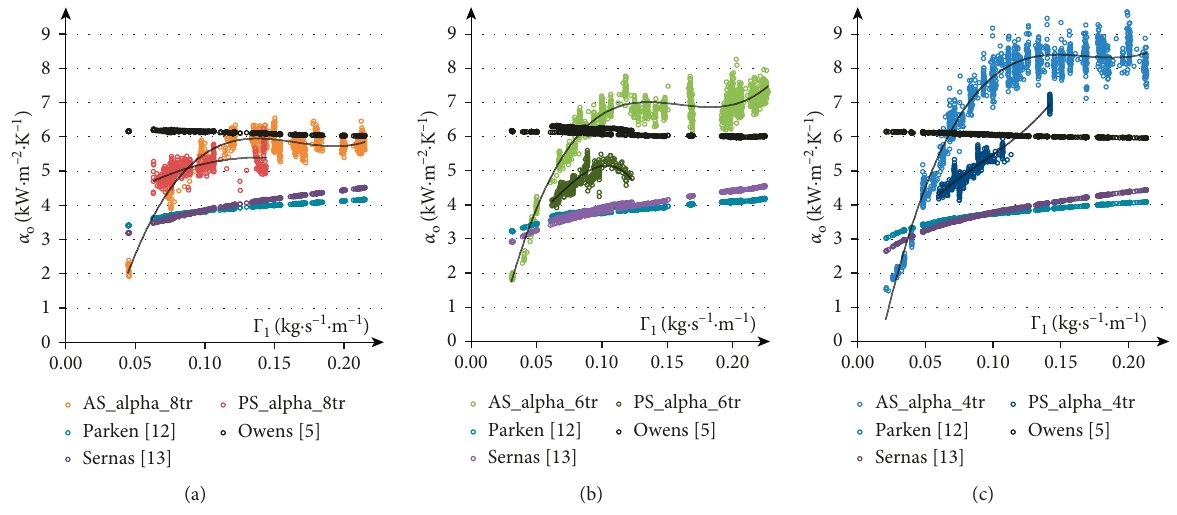
Figure 5: Comparison of heat transfer coefficients in relation to mass flow